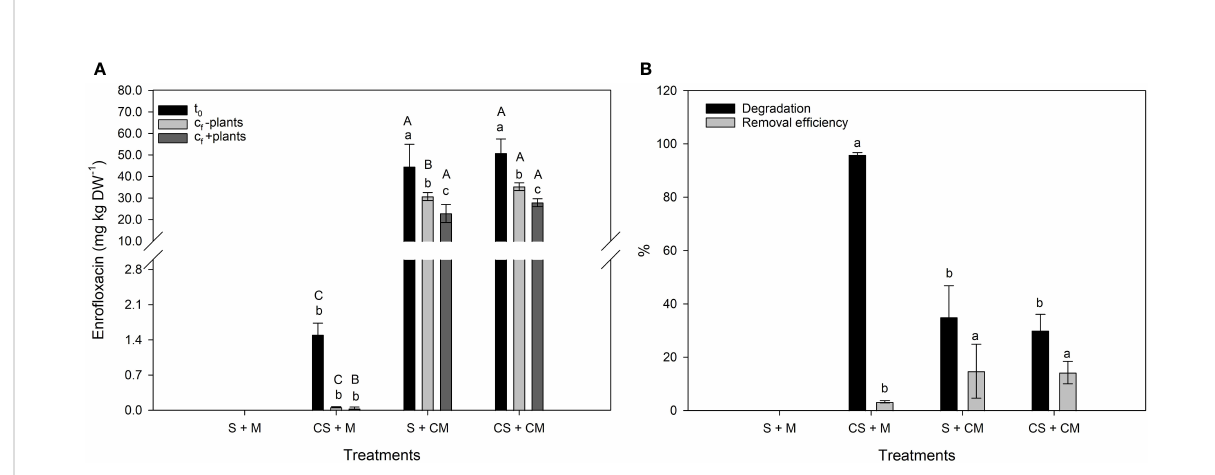
FIGURE 3 (A) Enro fl oxacin concentrations in substrate at the initial (C 0 ) and fi nal time (C f ) in the presence (+plants) or absence (-plants) of calla lily plants. Lower case letters indicate signi fi cant differences in Enro concentrations between t 0 , C f - plants and C f + plants within the same treatment; uppercase letters indicate signi fi cant differences in the pharmaceutical concentration between treatments within t 0 , C f - plants and C f + plants. (B) Natural degradation in substrates and Enro-removal ef fi ciency of calla lily plants. Different letters indicate signi fi cant differences between treatments. Bars represent the means ± SD of fi ve replicates. Soil (S) = 0 mg Enro kg -1 ; manure (M) = 0 mg Enro kg -1 ; Contaminated soil (CS) = 1.9 mg Enro kg -1 ; Contaminated manure (CM) = 50.4 mg Enro kg -1